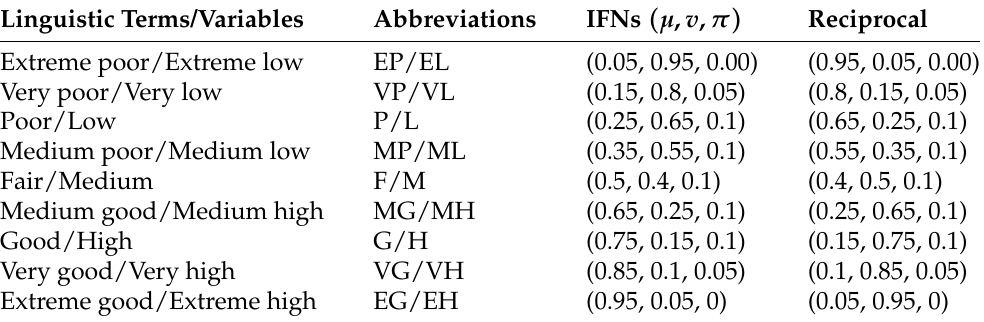
Table 1. Linguistic terms and corresponding IFN for pairwise comparison. (modified from [39])). Linguistic